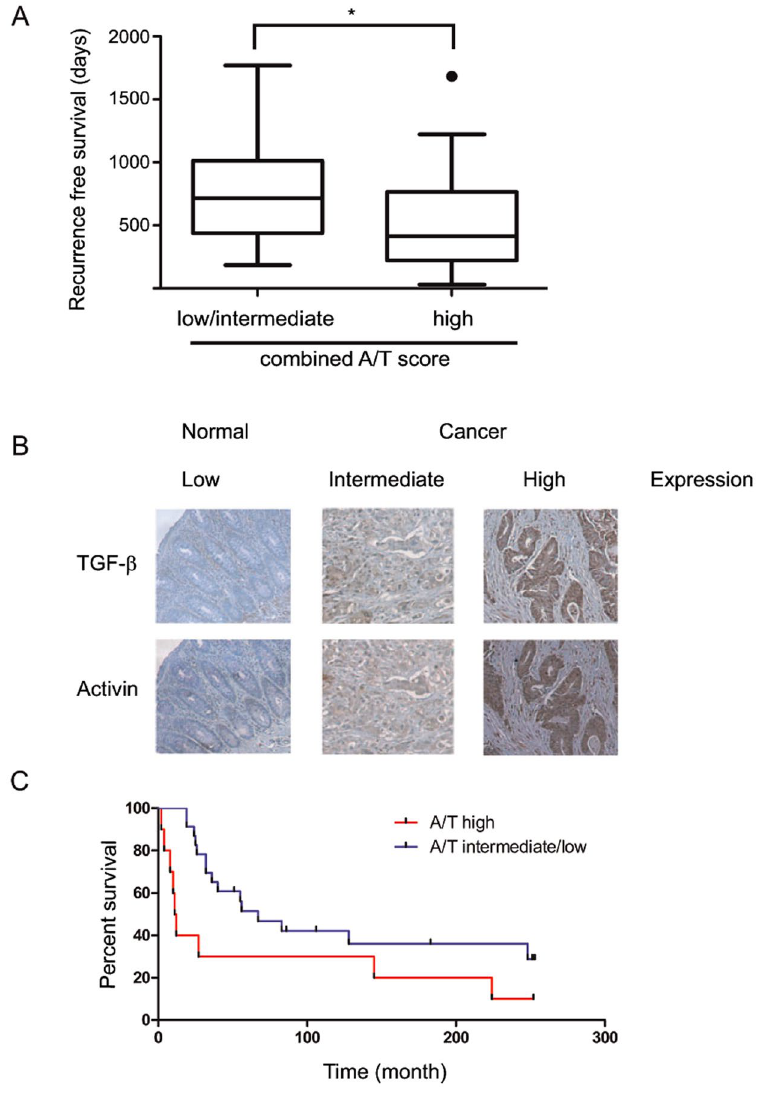
Figure 1. Combined activin and TGF- β ligand scores are strongly predictive of a worse prognosis in colorectal cancer. ( A ) Serum ligand levels are predictive of shorter recurrence-free survival. Sixty stage 2 CRC patients with recurrence were stratified by activin and TGF-b serum ligand expression and with median recurrence-free survival shown as box plots. The combined activin/ TGF- β score (A/T) is defined in the Materials and Methods. Low/intermediate is defined as a score of 4 or less and high is defined as a score of 5 or higher. ( B ) Tumoral activin and TGF- β expression are strongly correlated. Representative sections of immunohistochemical staining of TGF- β or activin ligand in a CRC TMA with examples of low, intermediate and high staining. Matched colon cancer sections of adjacent slides are shown to demonstrate correlation of activin and TGF- β expression. ( C ) Tumoral activin and TGF- β ligand are predictive of shorter overall survival. Kaplan Meier curve of patient survival in either activin/ TGF- β high (A/T) patients or A/T low as defined in the Materials and